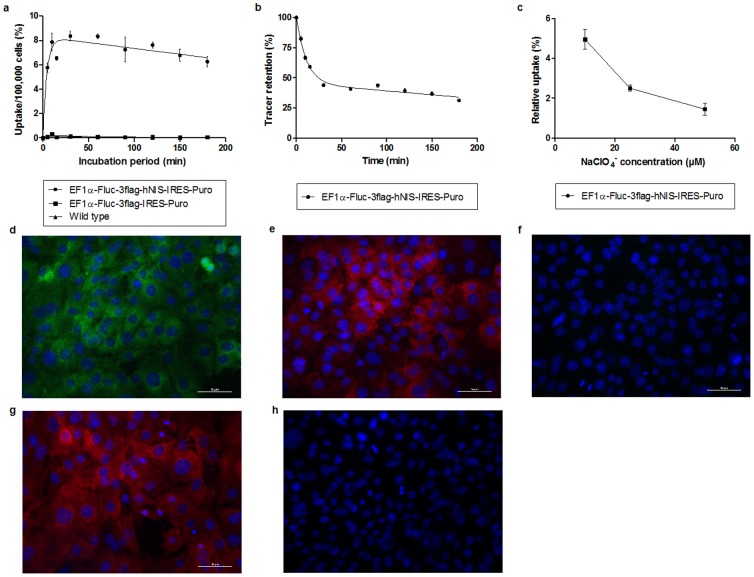
Validation of the multicistronic LV contruct.
99mTcO4
− uptake kinetics in MSCs transduced with the two different multicistronic LV constructs or wild type MSCs (a). Tracer elution from Fluc-hNIS expressing MSCs (b). The effect of different concentrations of NaClO4 on the uptake of 99mTcO4
− in Fluc-hNIS expressing MSCs (c). Immunocytochemistry against hNIS on Fluc-hNIS expressing MSCs and DAPI (d), against 3flag in 3flagFluc-hNIS expressing MSCs and DAPI (e) and negative control (f). Immunocytochemistry against 3flag in 3flagFluc expressing MSCs and DAPI (g) and negative control (h).